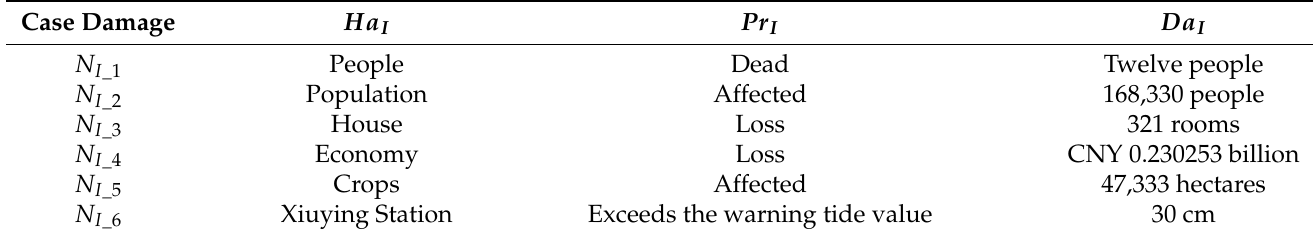
Table 8. Label information V I of storm surge disaster case no. 2.